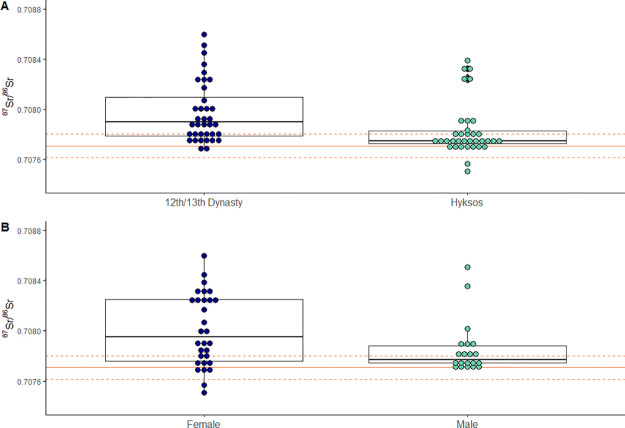
Comparing 87Sr/86Sr values by time period and sex.(A) Comparison of 87Sr/86Sr values of pre-Hyksos and Hyksos individuals. (B) Comparison of 87Sr/86Sr values of females and males.